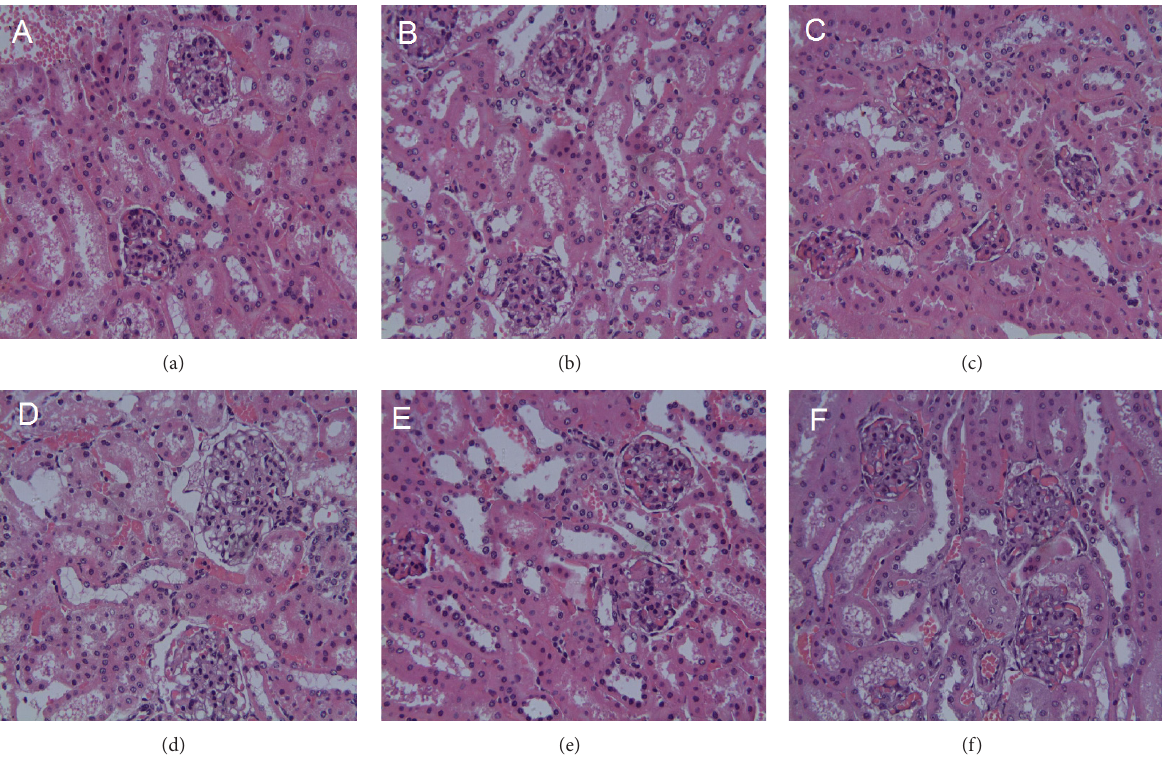
Figure 12: Pathological examination of renal tubule in db/db mice. (a) Renal tubule from a normal mouse. (b) Edema and degeneration of renal tubular epithelial cell from db/db mouse with no treatment. (c) Edema and degeneration of renal tubular epithelial cell from metformin- treated db/db mouse. (d), (e), and (f) Alleviation of degeneration of renal tubular epithelial cell from TNTL-treated db/db mouse at the dose of 3.6 g, 1.8 and 0.9 g/kg b.w.,